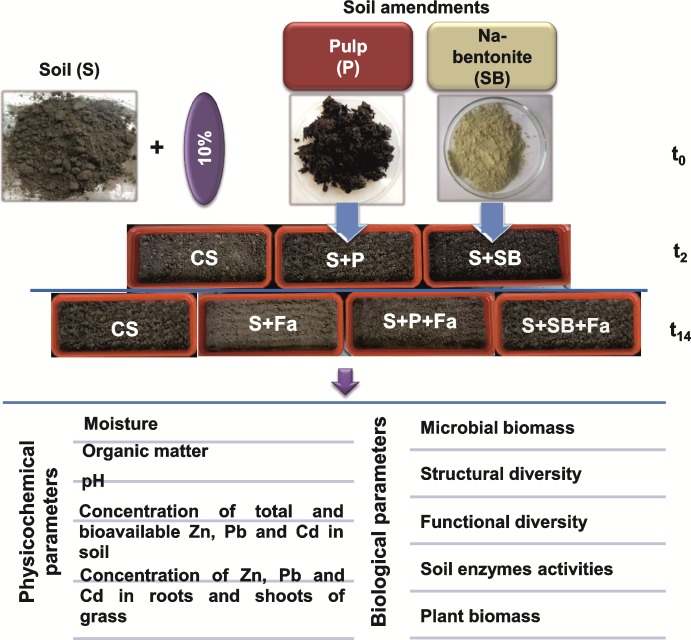
The scheme of experimental design.